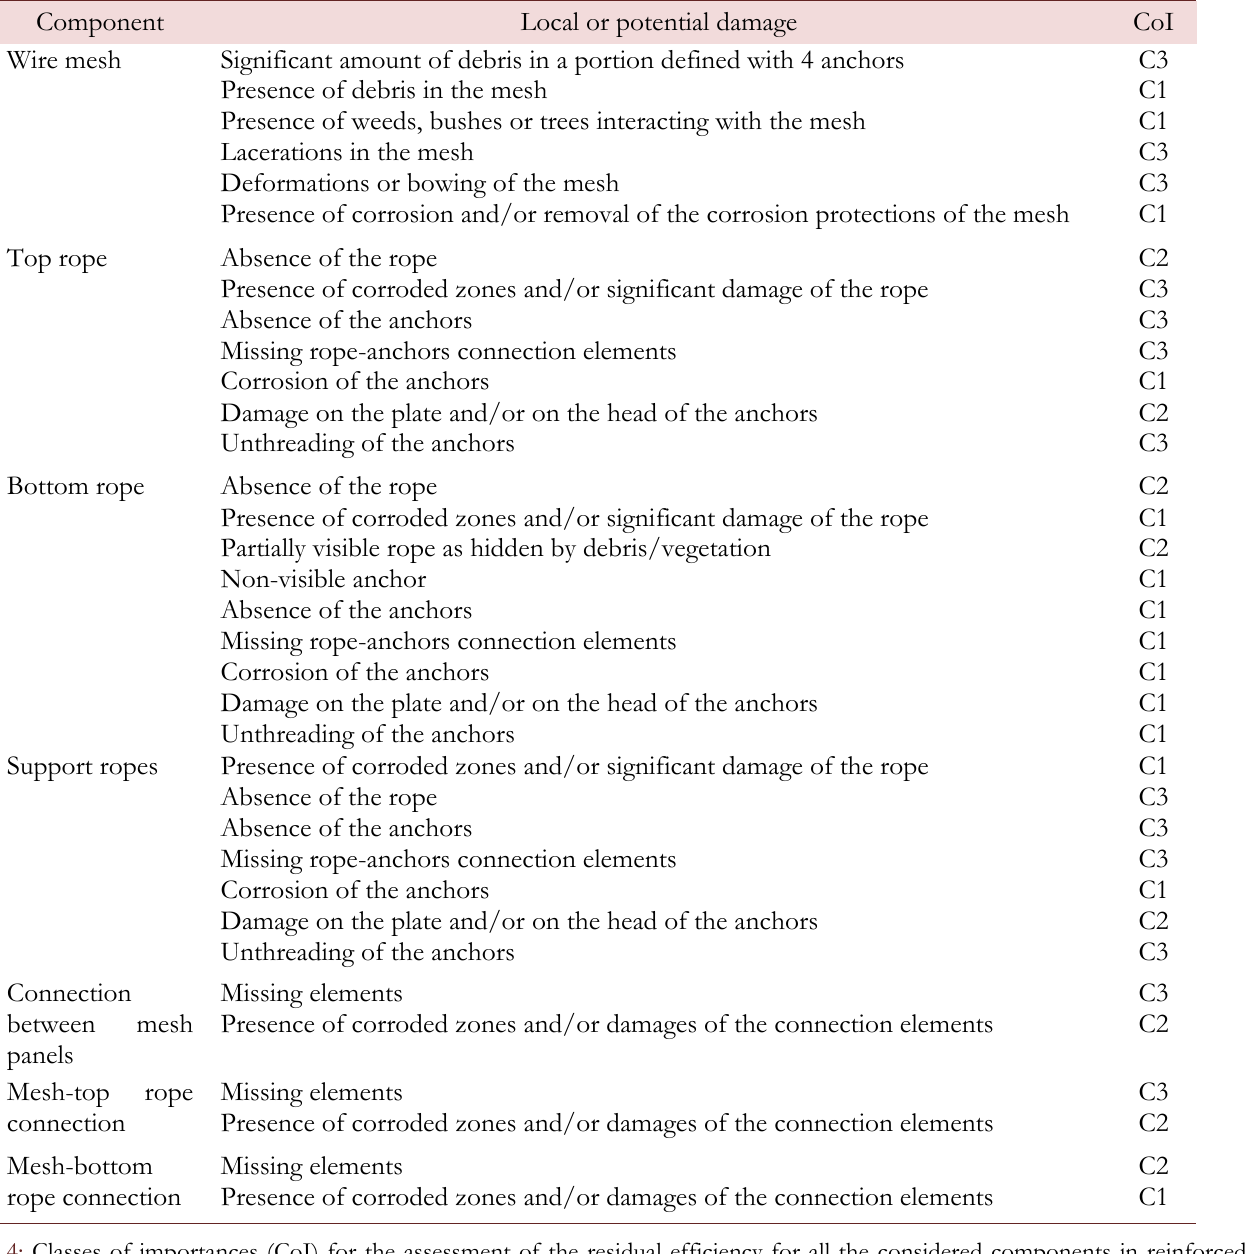
Table 4: Classes of importances (CoI) for the assessment of the residual efficiency for all the considered components in reinforced drapery net systems (maximum equal to 109).